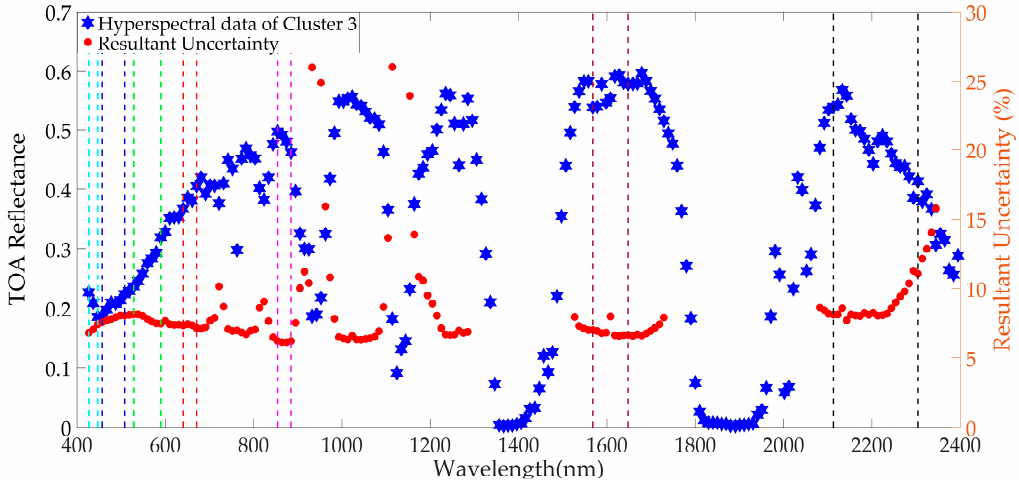
Remote Sens. 2019 , 10 , x FOR PEER REVIEW Figure A2. Estimated representative hyperspectral profile of Cluster 3 and its resultant uncertainty. Figure A2. Estimated representative hyperspectral profile of Cluster 3 and its resultant uncertainty. Figure A2. Estimated representative hyperspectral profile of Cluster 3 and its resultant uncertainty.